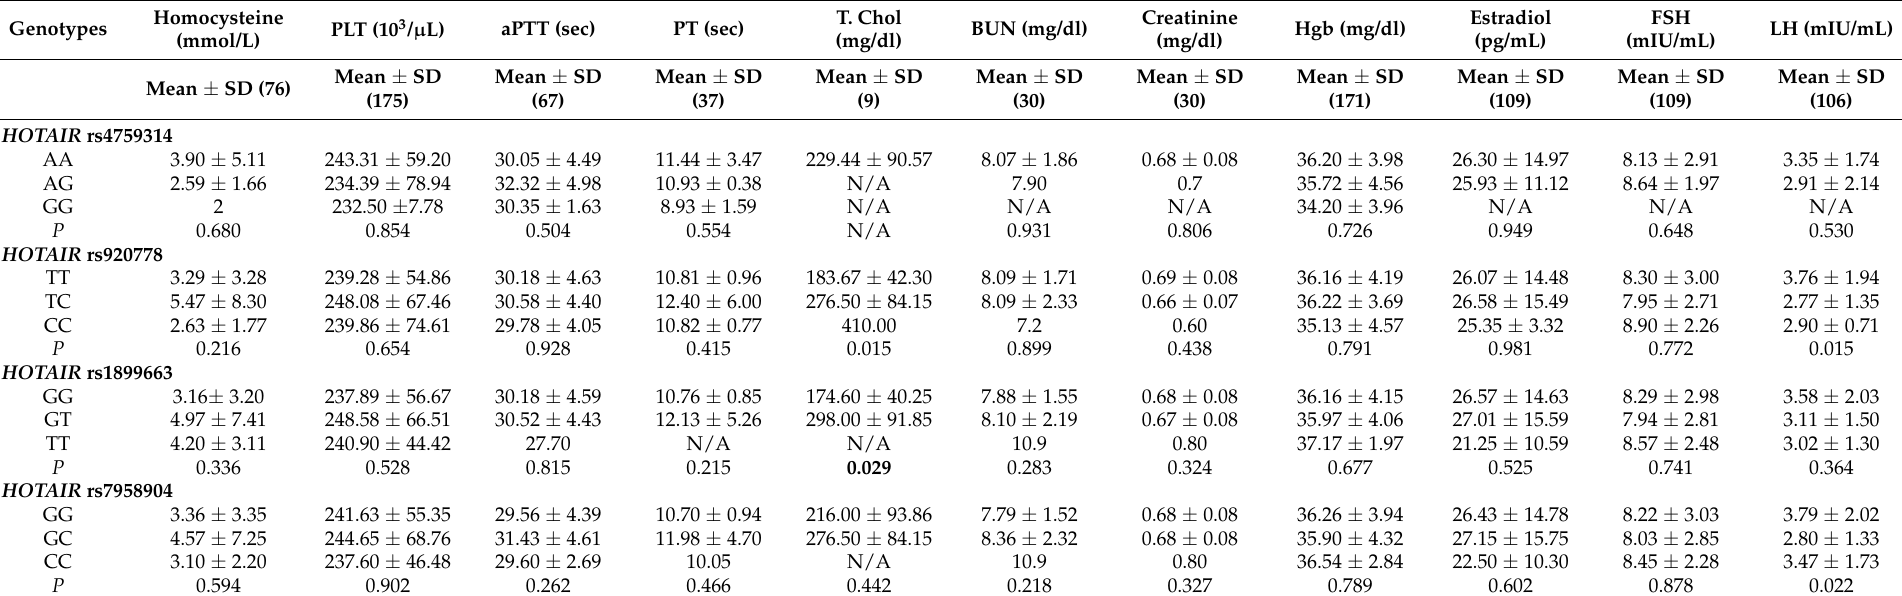
Table 7. Differences in various clinical parameters according to HOTAIR gene polymorphisms in control